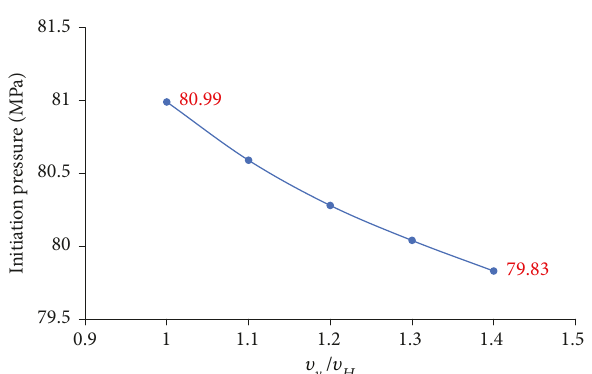
Figure 11: The relationship curve between initiation pressure and υ v / υ H .